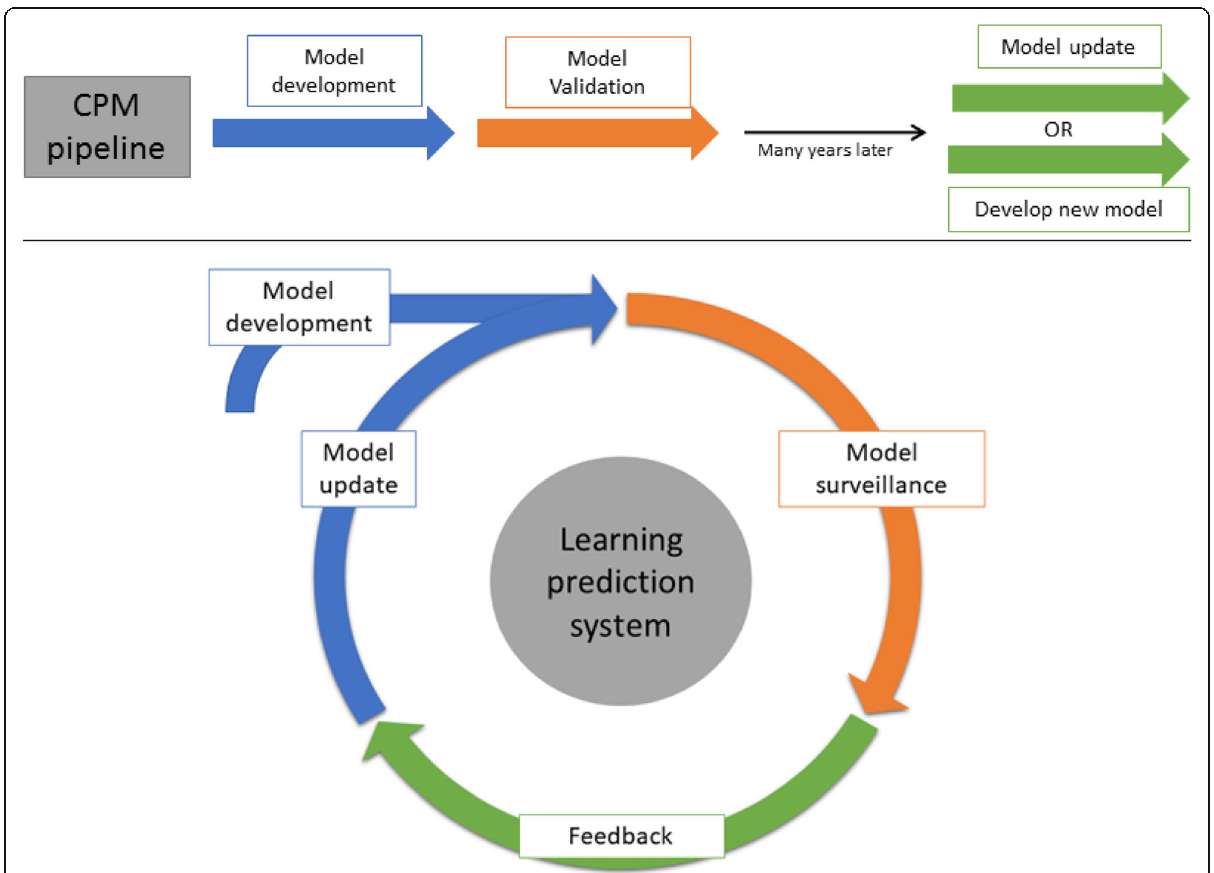
Fig. 1 Illustration of the current CPM pipeline (top) and the proposed learning prediction system